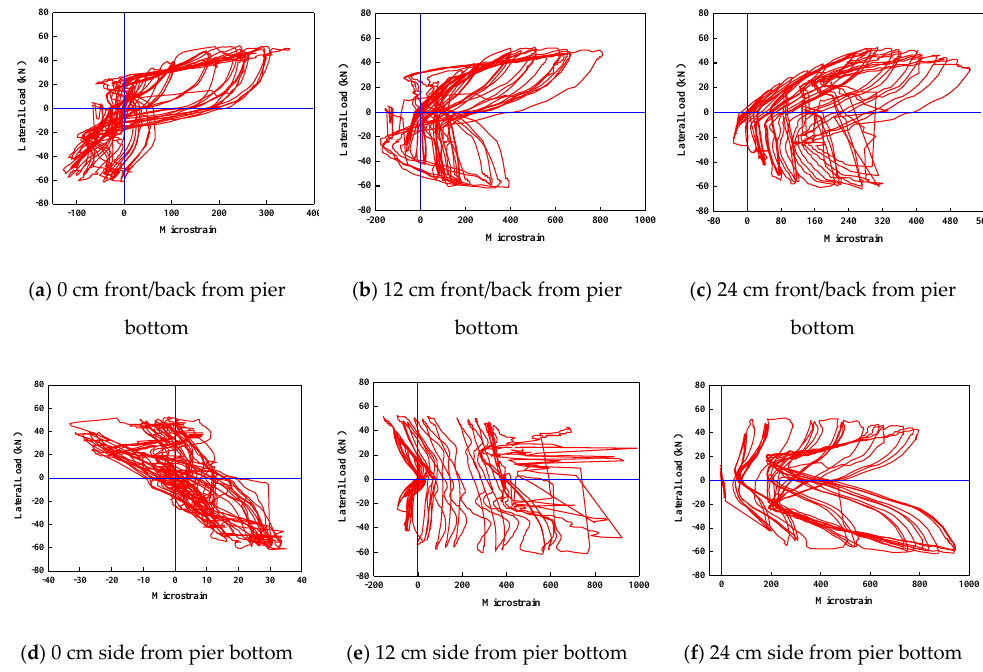
Figure 13. Lateral load-transverse reinforcement strain curves of PP-ECC-6 pier.